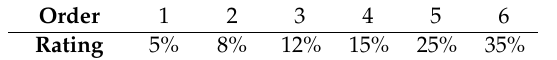
Table 4. Percentage of the total rating of the question for each vocational group.